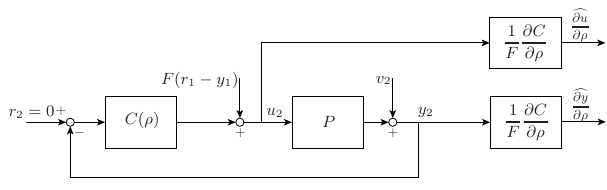
Figure 2. Block diagram of the closed-loop gradient